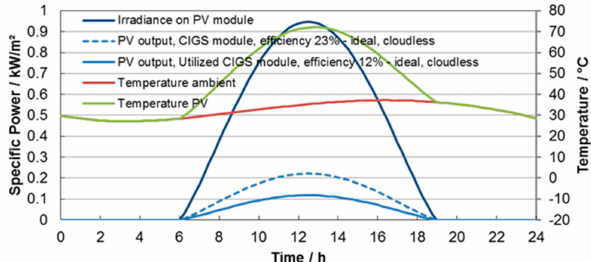
Figure 3. Theoretically possible power generation over the day. Temperature during a reference day in July. The blue curves show the irradiation and specific power that can be converted by the PV panel. The red curve shows the ambient temperature over a day in July and in green, the temperature of the PV panel is